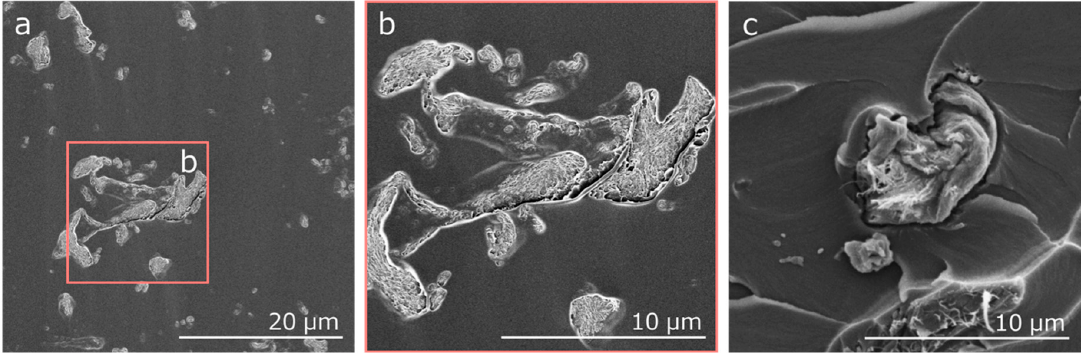
Figure 5. SEM images of ( a ) the surface for the 3.7 vol % CNF/epoxy composite, ( b ) the surface for the 3.7 vol % CNF/epoxy composite (high resolution), and ( c ) the fracture surface for the 0.73 vol